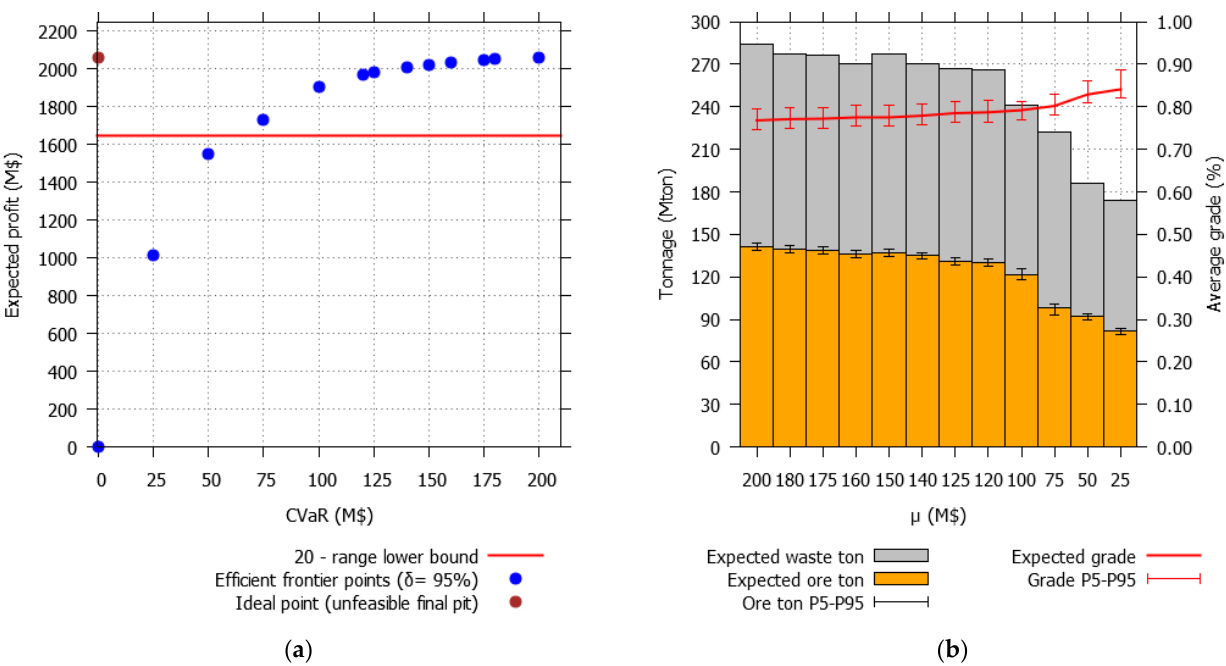
Figure 6. Results from efficient frontier applied on BMT block model: ( a ) Efficient frontier between risk (CVaR) and expected profit for the final pit alternatives, with a confidence level of 95%; ( b ) Graph showing ore and waste tonnages and average grade per final pit alternative when varying the parameter µ . Both graphs (ore and grade) include error bars with 5th and 95th percentile per interval.